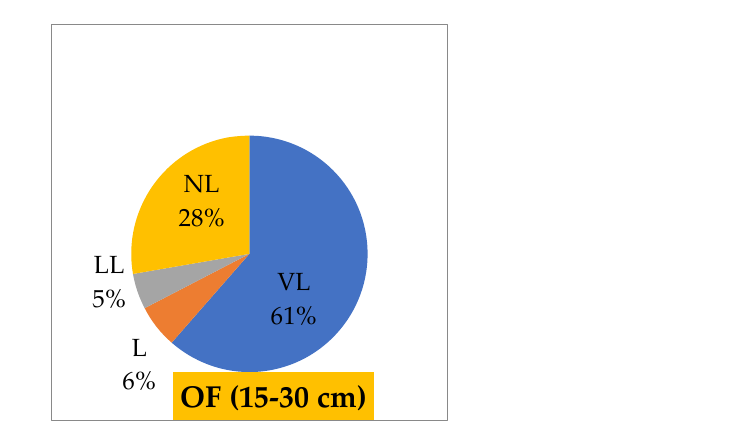
Figure 9. Effect of nutrient management on C fractions contribution (15–30 cm).